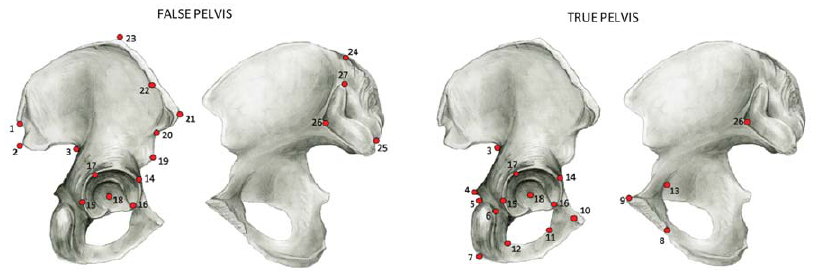
Figure 3. Landmark configurations for regions of the os coxae associated with the false and true pelvis. The acetabular region is included in both configurations.